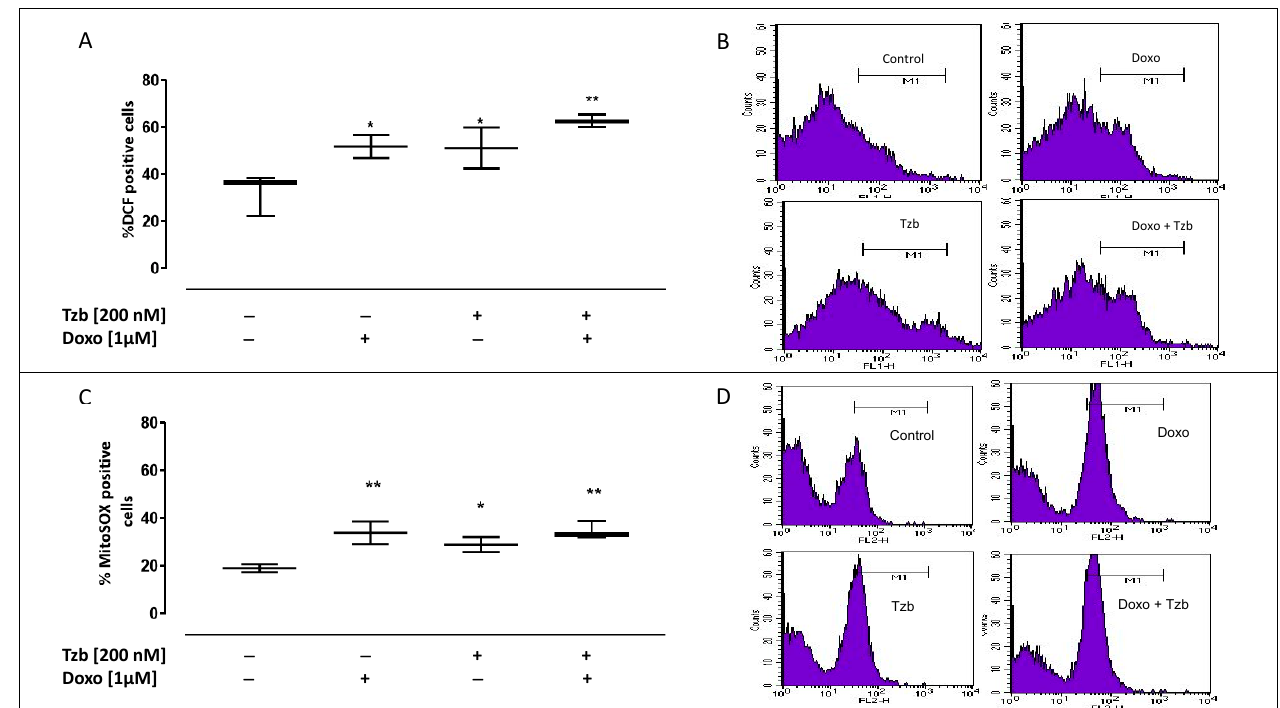
Figure 1. Effect of Doxo and Tzb and their association with cytosolic and mitochondrial ROS production. Doxo (1 µ M) was administered for 4 h, and Tzb (200 nM) was administered for 20 h. ROS formation was evaluated by means of 2 (cid:48) ,7 (cid:48) dichlorofluorescein diacetate (H2DCF-DA) probe in H9c2 cells. ROS production is expressed as mean ± SEM of percentage of DCF positive cells of at least three independent experiments, each performed in duplicate ( A ). Mitochondrial superoxide production was measured by means of the probe MitoSOX Red in H9c2 cells through flow cytometry analysis, and it is expressed as mean ± S.E.M. of MitoSOX positive cells percentage of at least three independent experiments each performed in duplicate ( C ). Data were analysed by variance test analysis, and multiple comparisons were made by Bonferroni’s test. * p < 0.05 and ** p < 0.005 vs. non-treated cells. Panels ( B , D ) report representative histograms for the flow cytometry analysis of DCF and MitoSOX,